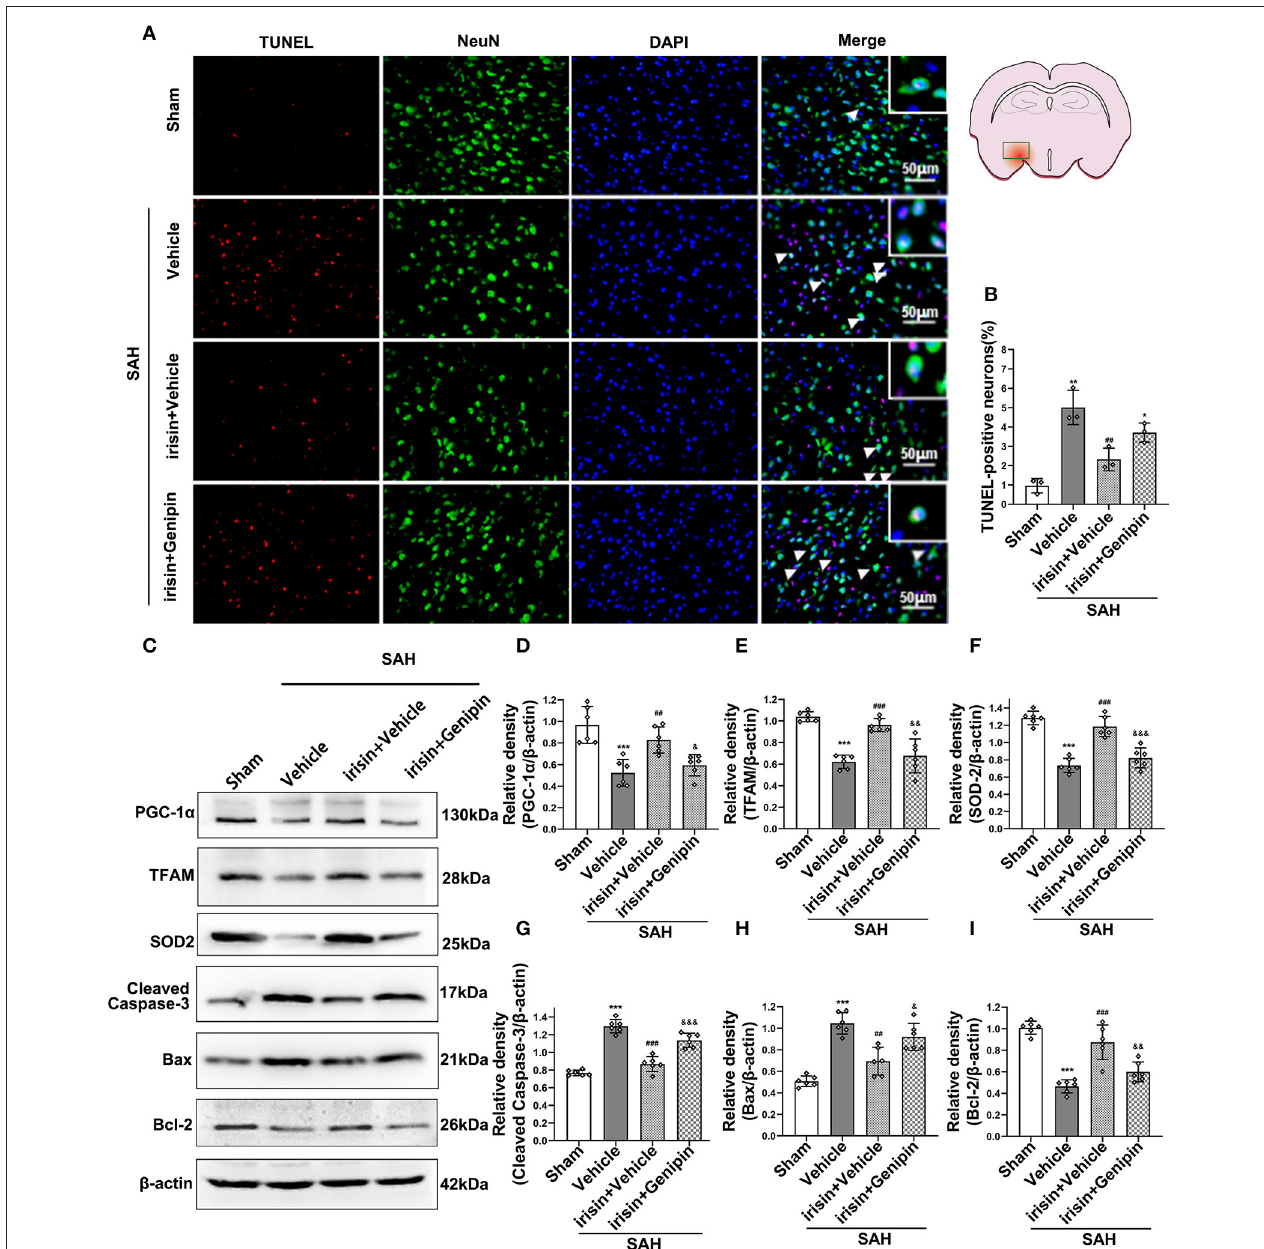
FIGURE 8 | Inhibition of UCP-2 pathway reversed the beneficial effects of irisin on apoptosis, mitochondrial function, and oxidative stress after SAH. (A,B) TUNEL-positive neurons were significantly increased after genipin administration in the irisin treatment group. Scale bar = 50 µ m, n = 3 for each group (The area of observation was circled in red). (C–I) Representative western blotting images and relative density analysis of proteins related to mitochondrial biogenesis (TFAM, PGC-1 α ), oxidative stress (SOD2), and apoptotic markers (Cleaved caspase-3, Bax, Bcl-2) at 24h after SAH. As an exogenous UCP-2 inhibitor, genipin significantly blunted the expressions of PGC-1 α , TFAM, SOD2, and Bcl-2 (D,E,F,I) and resulted in an increased level of cleaved caspase-3 and Bax (G,H), n = 6 for each group. All data were presented as mean ± SD. The one-way ANOVA was used followed by the Tukey’s HSD post-hoc test and the Holm–Bonferroni correction method. * P < 0.05, ** P < 0.01, *** P < 0.001 vs. Sham group; ## P < 0.01, ### P < 0.001 vs. SAH + Vehicle group. & P < 0.05, && P < 0.01, &&& P < 0.001 vs. SAH + irisin + Vehicle group. Vehicle group, sterile 0.9% of NaCl; TUNEL, TdT-UTP nick end labeling; SOD, Superoxide Dismutase; UCP-2, Uncoupling